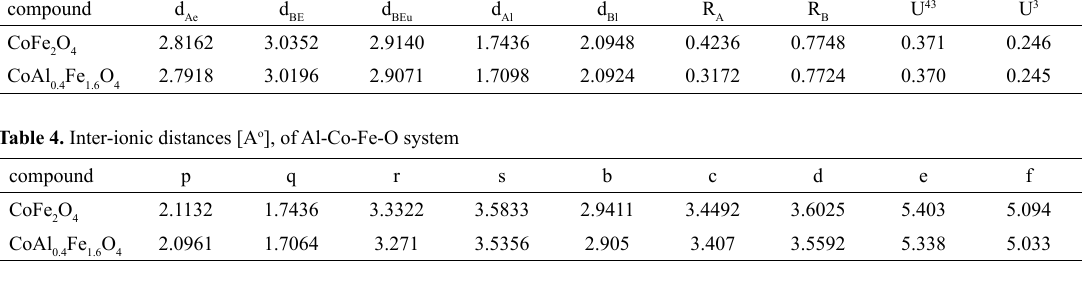
Table 5. Bond angles (degree) of Al-Co-Fe-O system compound